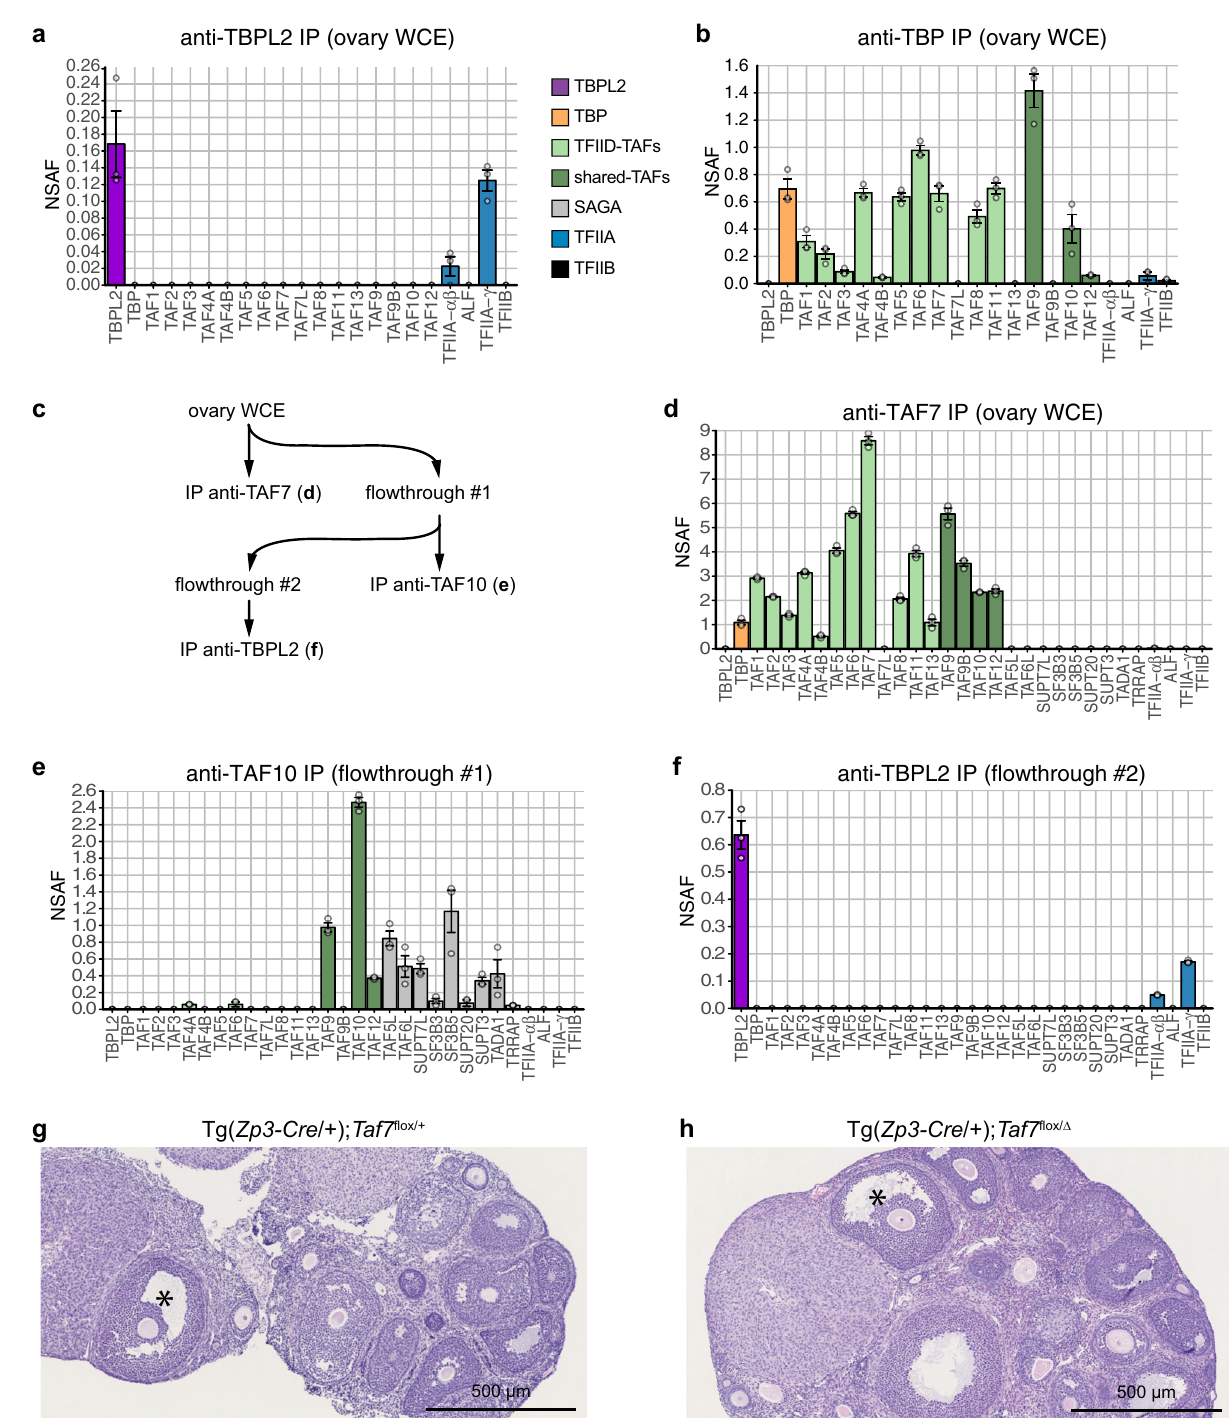
Fig. 1 TBPL2 does not assemble in a TFIID-like complex in growing oocytes. a Anti-TBPL2 immunoprecipitation followed by mass spectrometry (IP-MS) analysis from three biological replicates of mouse ovarian whole-cell extracts (WCE). The colour code for the different proteins or complexes is indicated on the right. NSAF; normalised spectral abundance factor. b Anti-TBP IP-MS from ovarian WCE (three technical triplicates). The colour code is the same as in ( a ). c – f Sequential IP-MS experiment from ovarian WCE (three technical triplicates). The strategy of the sequential immunoprecipitation ( c ), anti-TAF7 IP-MS ( d ), followed by an anti-TAF10 IP-MS ( e ) and then an anti-TBPL2 IP-MS ( f ). The colour code is the same as in ( a ). g , h Representative views of haematoxylin and eosin-stained ovaries sections from control ( g ) and oocyte-speci fi c Taf7 mutant (Tg( Zp3-Cre / + ); Taf7 fl ox/ Δ , h ) ovaries (analyses of three sections from three biological replicates). The presence of antral follicles is indicated by an asterisk. Scale bars: 500 µ m. In ( a , b , d – f ) grey dots indicate replicates and error bars, + / − standard error of the